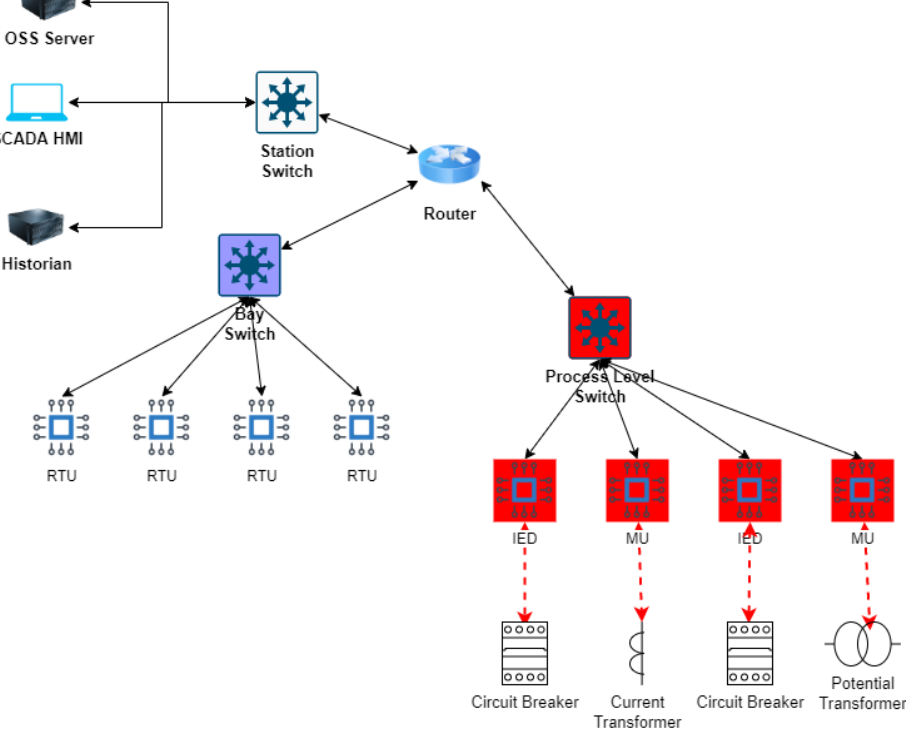
Figure 4. Substation automation